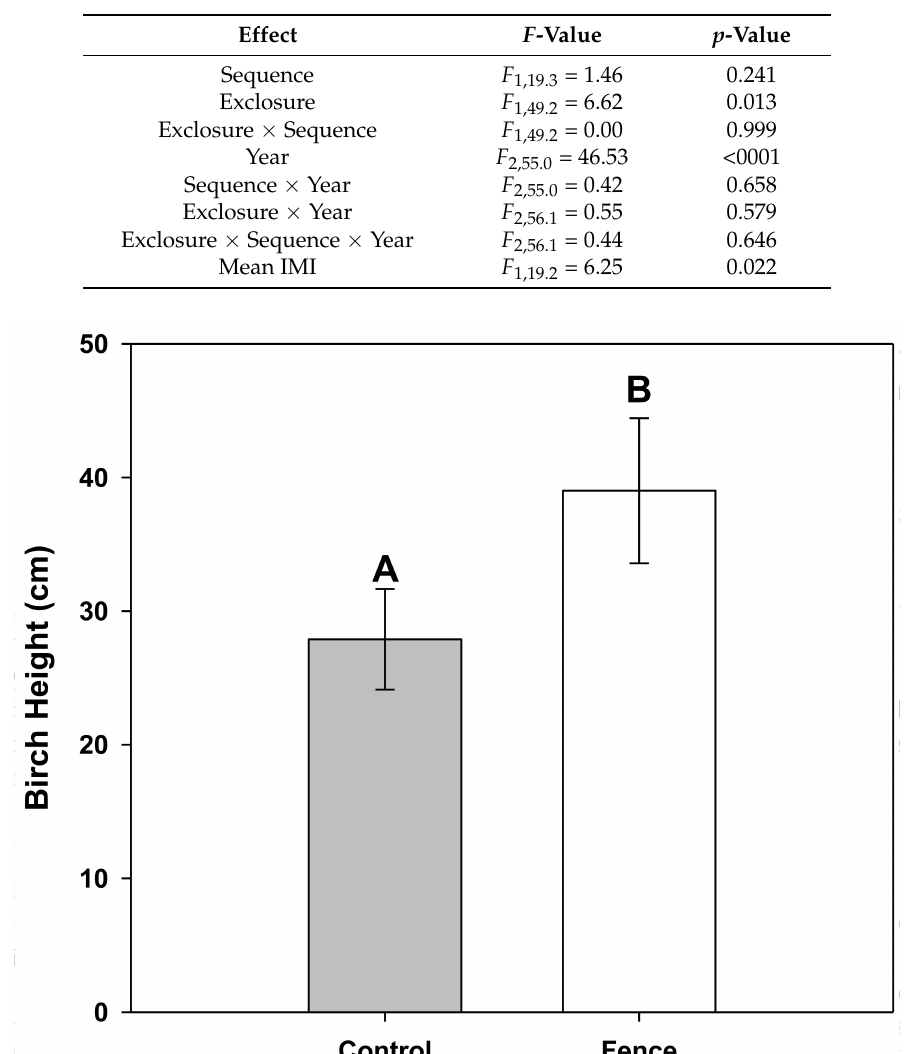
Table 2. Final generalized linear mixed model for established birch seedling height. The model-building phase did not identify any of the site-level covariates as sufficiently important for inclusion in final model. IMI: integrated moisture index.